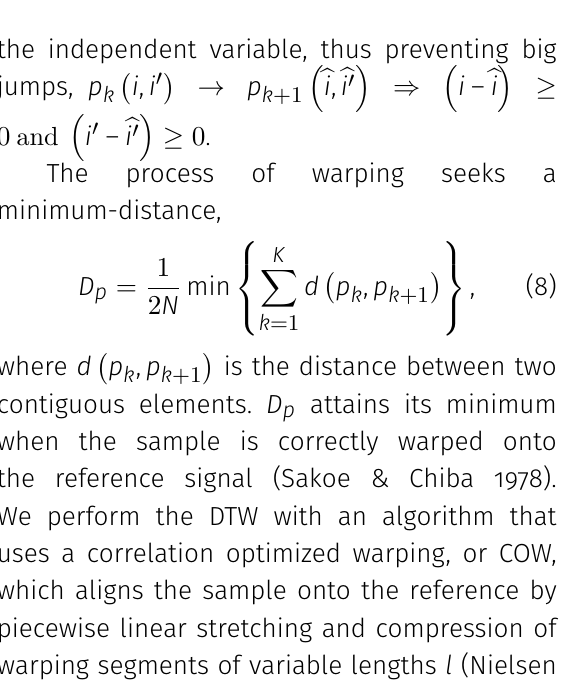
Figure 4. Standartized series ˜ ρ v , in red, and ˜ ρ w , in black. Panel ( a ) shows the original series and the relative shifts which should be applied to ˜ ρ v in order to align it to ˜ ρ w , the vector lengths proportional to the amount of shift. Panel ( b ) shows the aligned